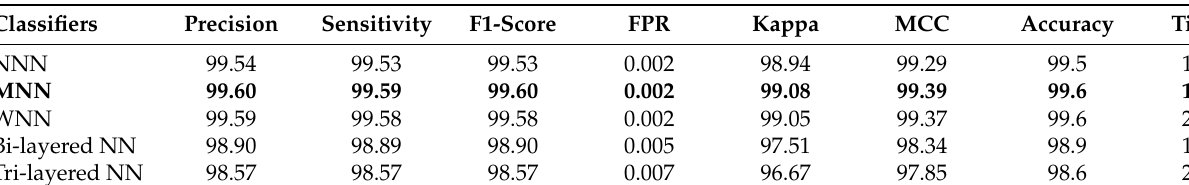
Table 3. Proposed improved CCA fusion results on Chest X-ray dataset.